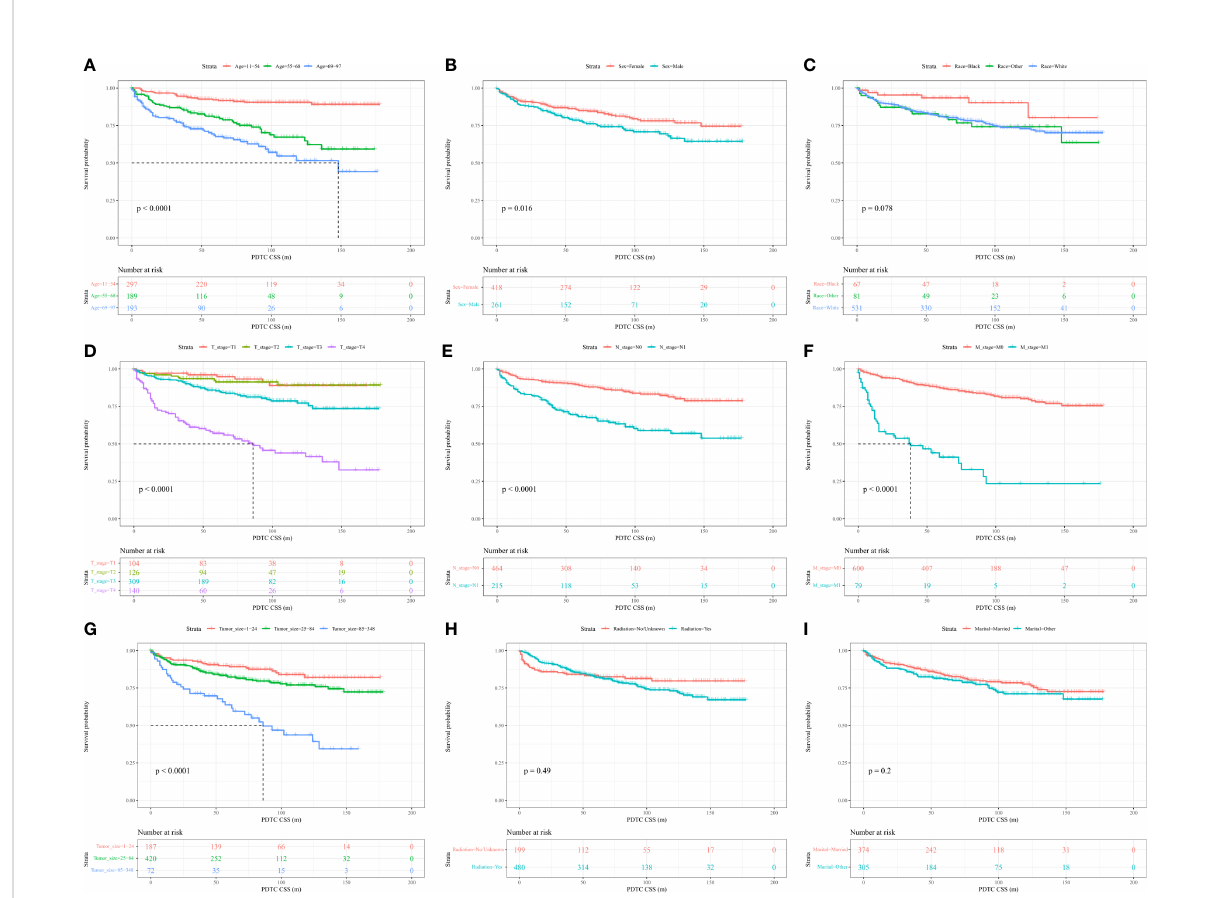
FIGURE 2 Kaplan – Meier curves and log-rank testing of cancer-speci fi c survival (CSS) in relation to various variables in patients with poorly differentiated thyroid carcinoma